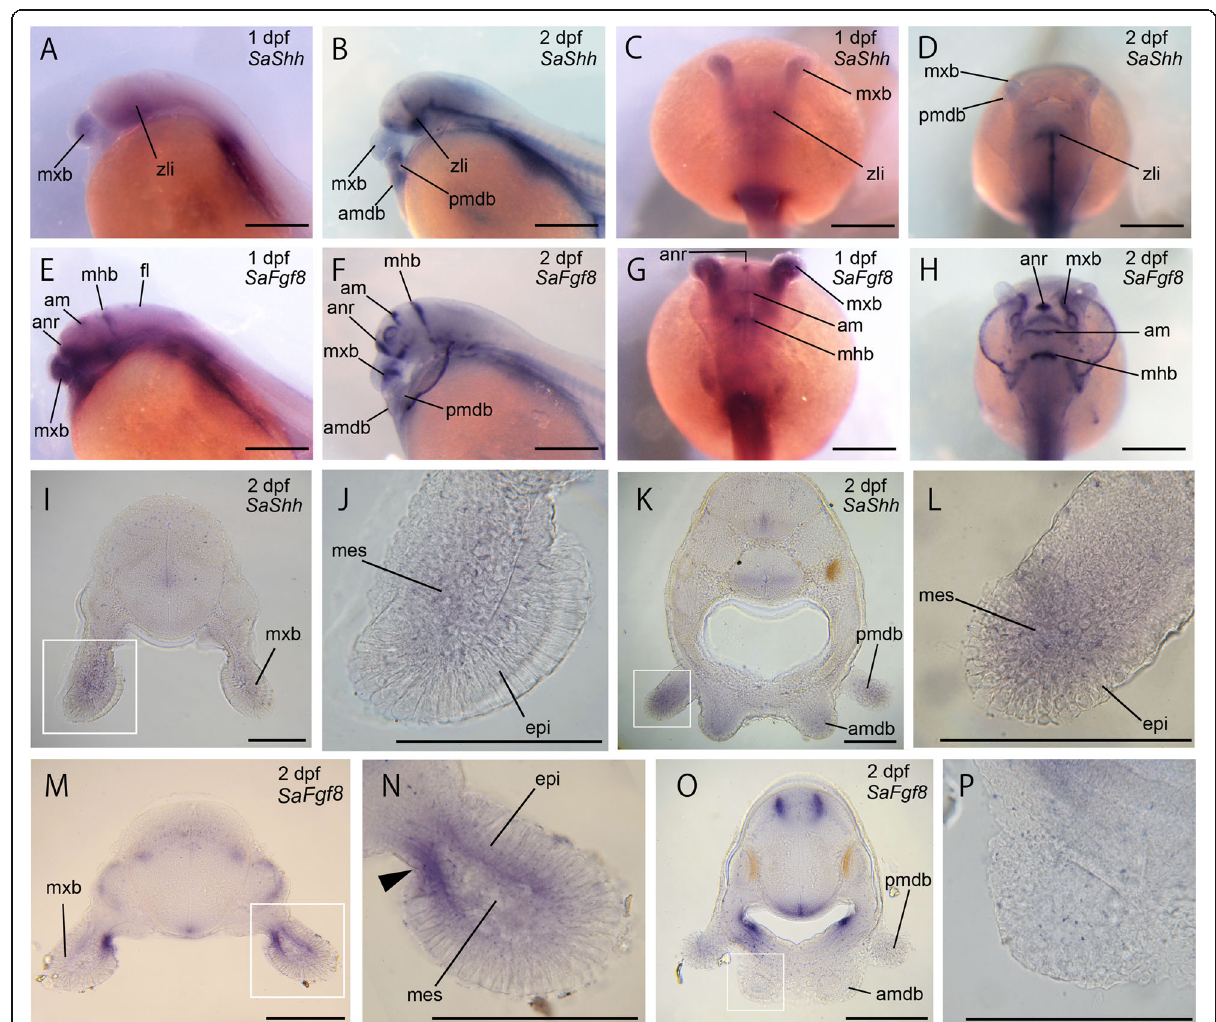
Fig. 5 Expression pattern of catfish orthologs of Shh ( SaShh ) and Fgf8 ( SaFgf8 ). a – d , transcripts of SaShh in Amur catfish embryos at 1 dpf ( a , c ), 2 dpf ( b , d ) are shown. e – h , transcripts of SaFgf8 in Amur catfish embryos at 1 dpf ( e , g ), 2 dpf ( f , h ) are shown. a , b , e , f are lateral views. c , d , g , h are dorsal views. Anterior is left in a , b , e , f and the upper side in c , d , g , h . i – p , coronal sections of Amur catfish embryos at 2 dpf. i , m and k , o are the slice of anterior and posterior head, respectively. i - l , transcripts of SaShh are shown. m – p , transcripts of SaFgf8 are shown. j , l , n an d p are high magnification images of boxes in i , k , m and o . Arrowhead indicates SaFgf8 expression domain at the medial epidermal layer. am, anterior midbrain; amdb, anterior mandibular barbel; anr, anterior neural ridge; epi, epidermis; fl, facial lobe; mes, mesenchyme; mhb, midbrain – hindbrain boundary; mxb, maxillary barbel; pmdb, posterior mandibular barbel; zli, zona limitans intrathalamica. Scale bars are 500 μ m in A – G, and 200 μ m in i –